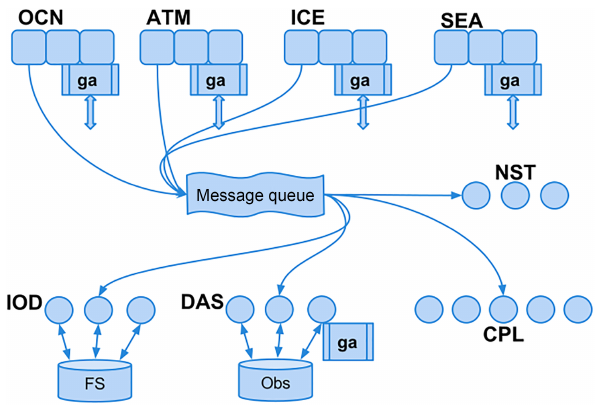
Figure 6. The architecture of the compact framework CMF3.0. There are four components in this example: ocean model (OCN), ice model (ICE), atmosphere model (ATM) and sea model (SEA). The components send requests to the common message queue, from where they are retrieved by the coupler (CPL), data assimilation (DAS), input and output data (IOD), and nesting (NST) services. The data itself is transferred through the mechanism of global ar- rays, which is also used for inter-processor communications in the components and